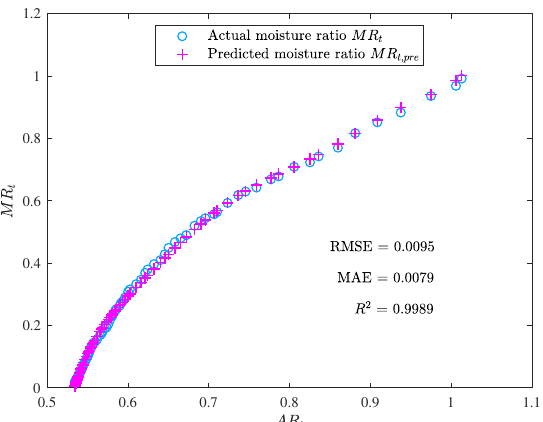
Figure 11. The prediction performance of the ELM model (the moisture ratio predicted by the ELM model MR t , pre vs. the area ratio AR t